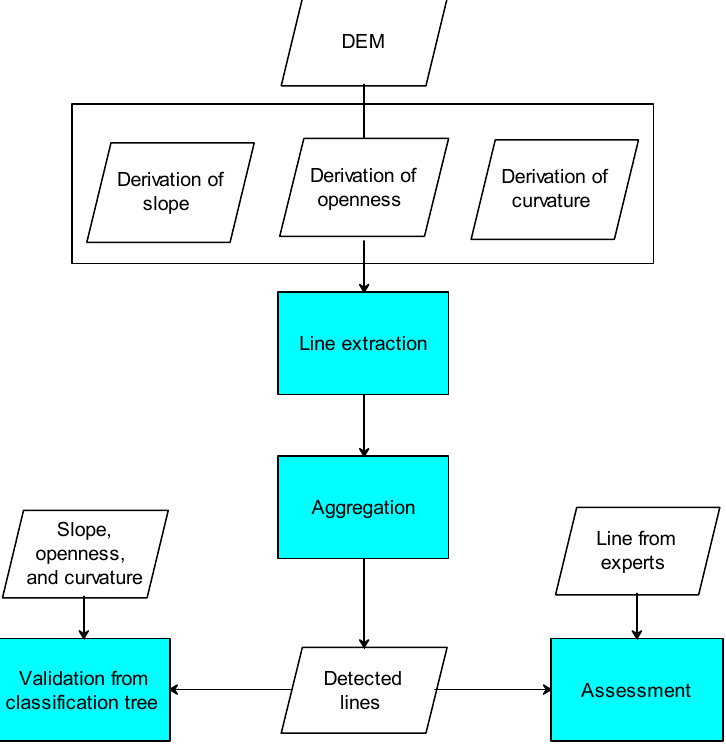
Figure 3. Main processes of vegetation garden wall detection and rule extraction.